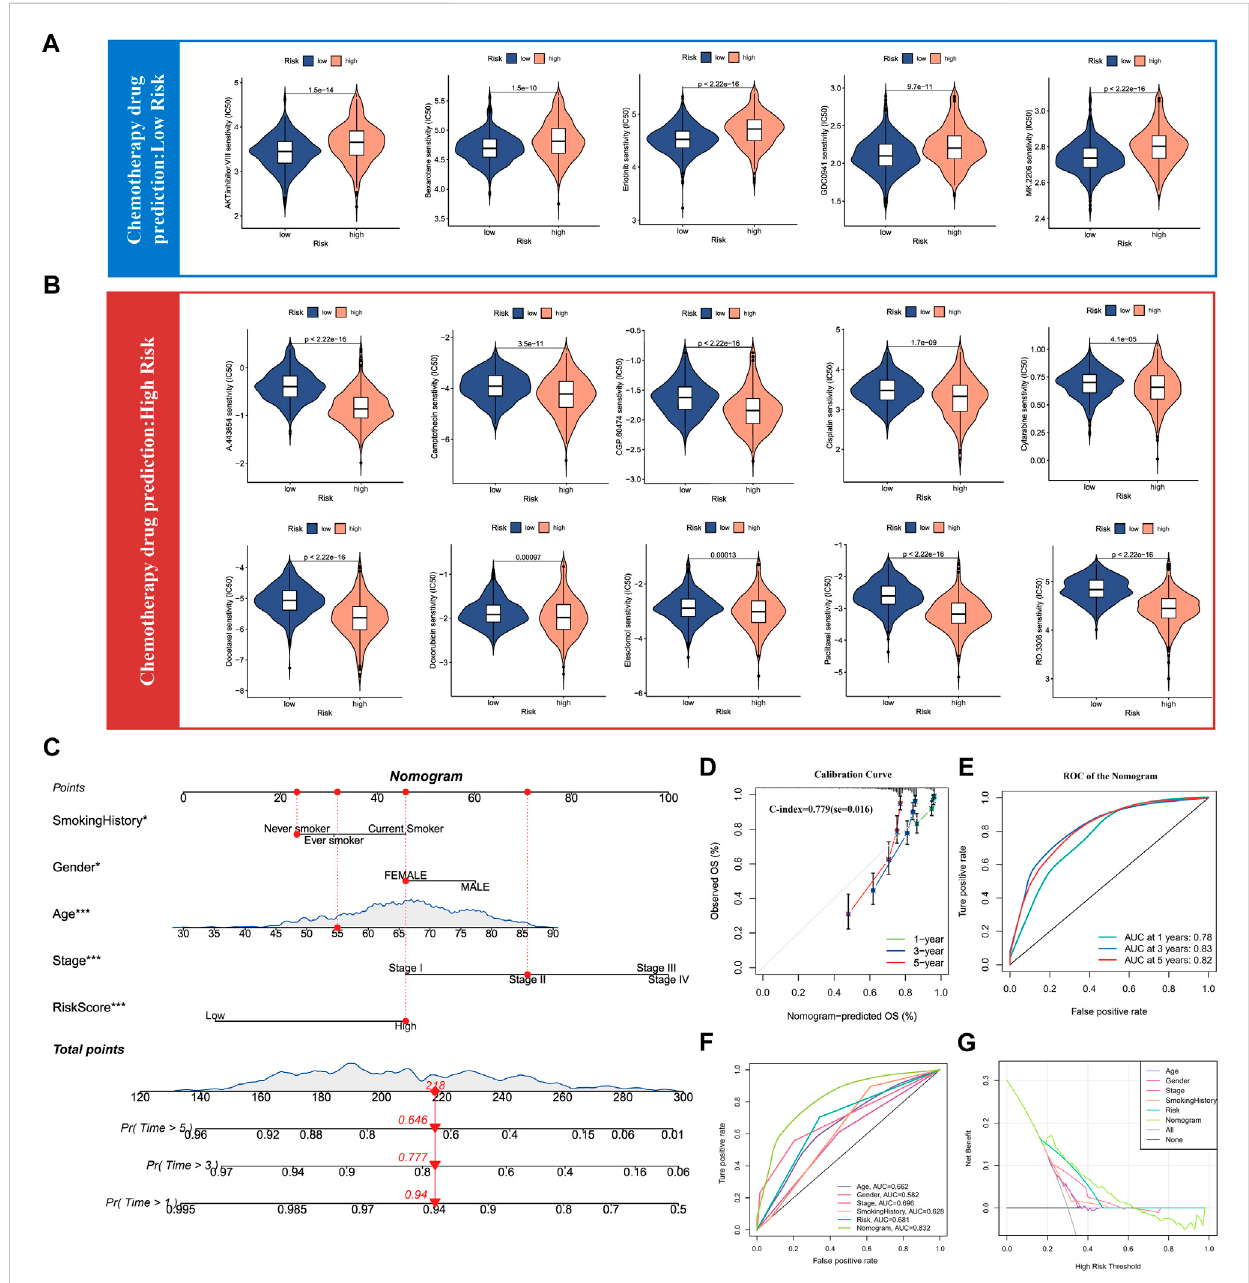
FIGURE 8 Drug sensitivity analysis of chemotherapy for lung adenocarcinoma and Nomogram construction. (A) Chemotherapy drug sensitivity analysis in patientswithlowSUMOylationscore. (B) ChemotherapydrugsensitivityanalysisinpatientswithhighSUMOylationscore. (C) ConstructionofNomogram by combining independent prognostic features such as smoking history, gender, age, pathological stage, and SUMOylation score. (D) Calibration curves for evaluating the predictive performance of Nomogram for 1, 3, and 5-year OS in lung adenocarcinoma patients. (E) The AUC for assessing the accuracy of Nomogram to forecast 1-, 3-, and 5- years overall survival. (F) The AUC for predicting 3-year overall survival for comparing the accuracy of various prognostic characteristics. (G) Decision Curve Analysis (DCA) shows the ef fi cacy of Nomogram and other prognostic features for clinical